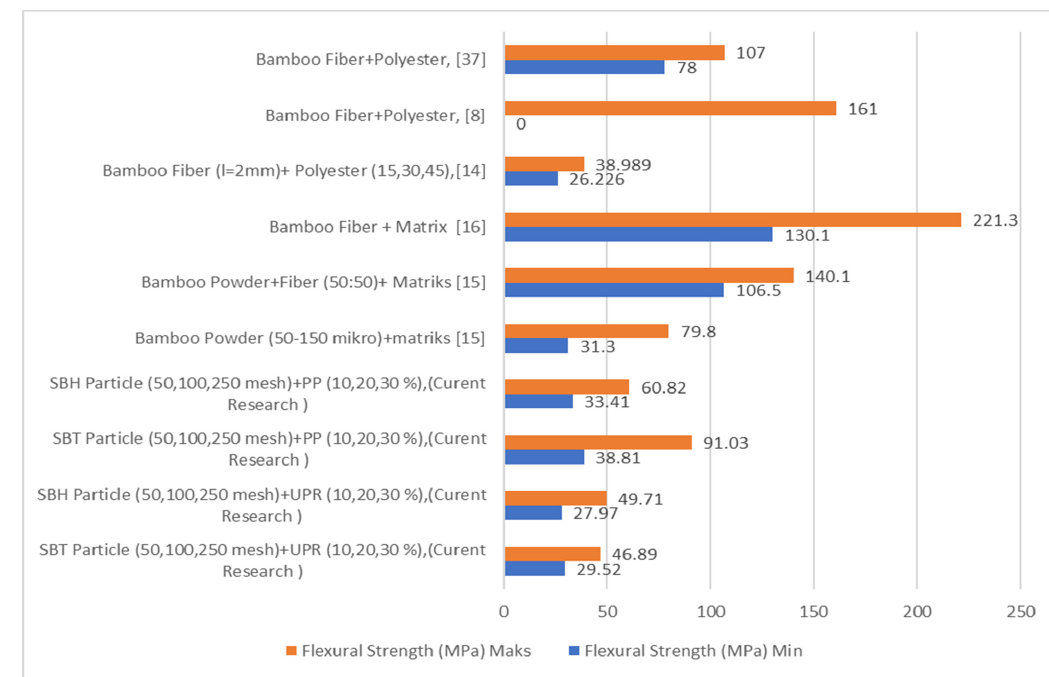
Figure 8. Comparison of the flexural strength of bamboo–polyester composites from previous and current research.